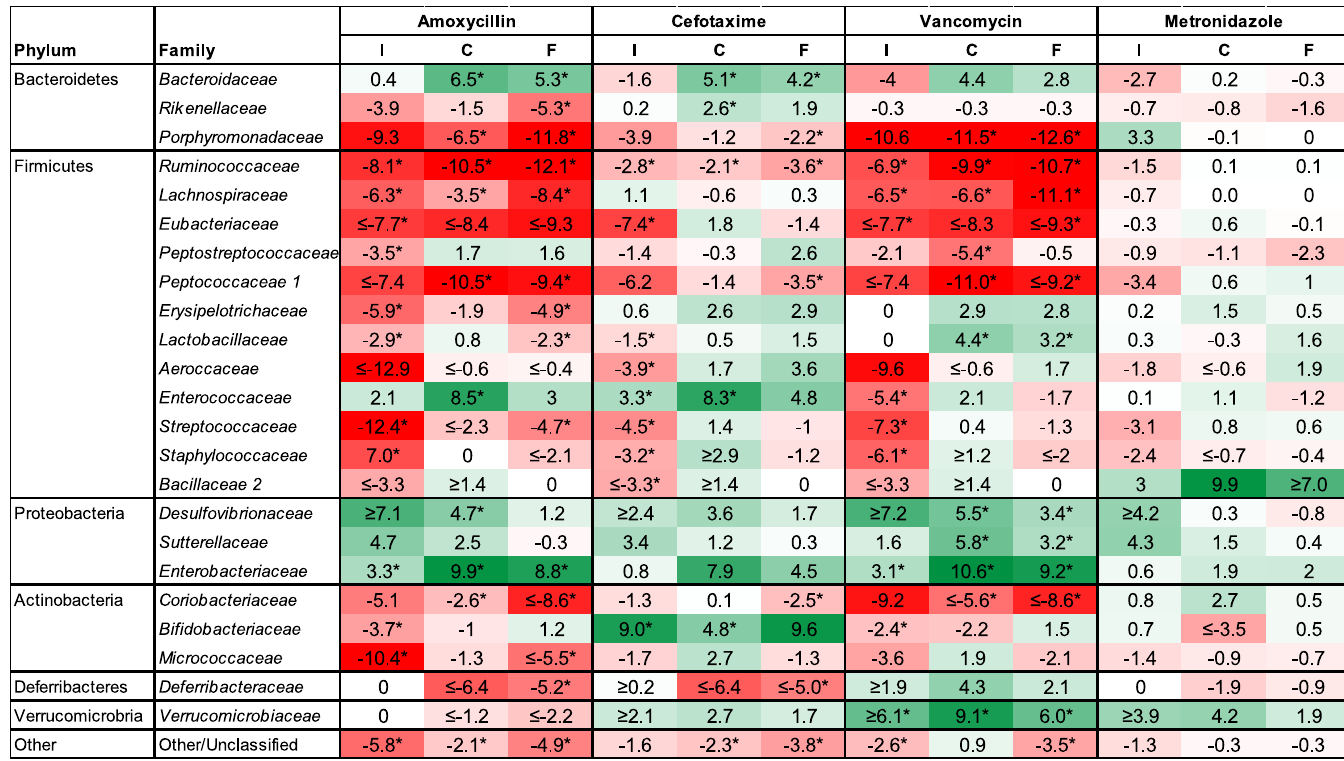
Fig 3. Fold change of bacterial families for treatment groups compared to the control group in ileum, caecum and faeces. Values show fold-changes (log 2 ) in relative abundance (rel. abun.) of bacterial families in ileum (I), caecum (C) and faeces (F) of antibiotic treated groups (ABX) compared to the same bacterial groups in the control (CON) group (log 2 (rel. abun. ABX / rel. abun. CON)). Only bacterial families which change significantly are shown. Intensity of green and red shading indicate levels of increase or decrease respectively and asterisks indicate significant differences after correcting for multiple testing (q < 0.05). When no reads were observed for a specific family, a value of 0.0005% was applied as a lower detection limit for calculations (fold-changes indicated with (cid:3) or (cid:1)